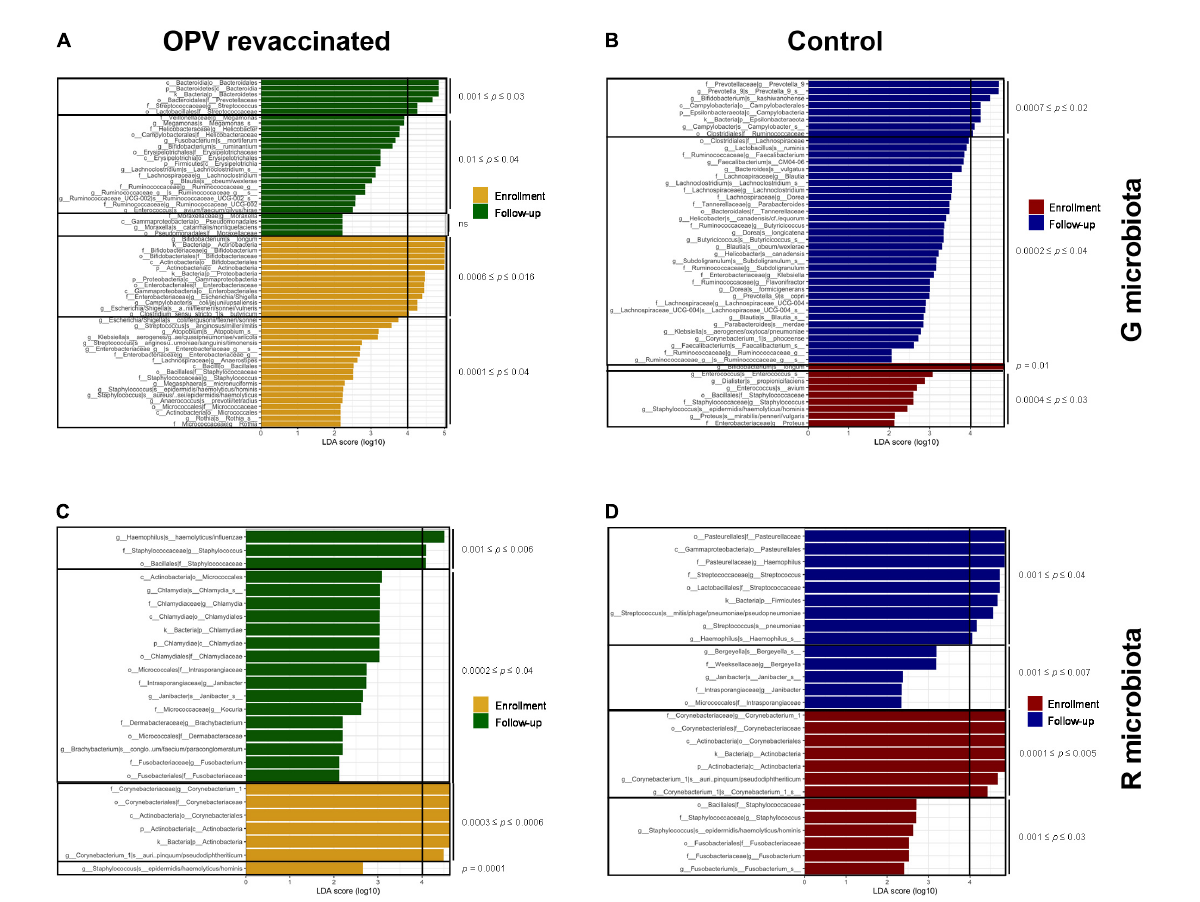
FIGURE4 LefSe analysis on species level and higher hierarchical groups identified taxa groups that significantly changed over time. Taxa in yellow and dark red significantly decreased over time, whereas taxa in green and blue significantly increased over time in G and R microbiotas in oral polio vaccine (OPV) revaccinated [ (A,C) , respectively], and Control [ (B,D) , respectively]. Adjusted p -values are displayed separately for taxa with 0 ≤ LDA score (log10) < 4 and LDA score (log10) ≥ 4. Taxa with highest effect size [LDA score (log10) ≥ 4] are the most responsible for the significant difference over time in each